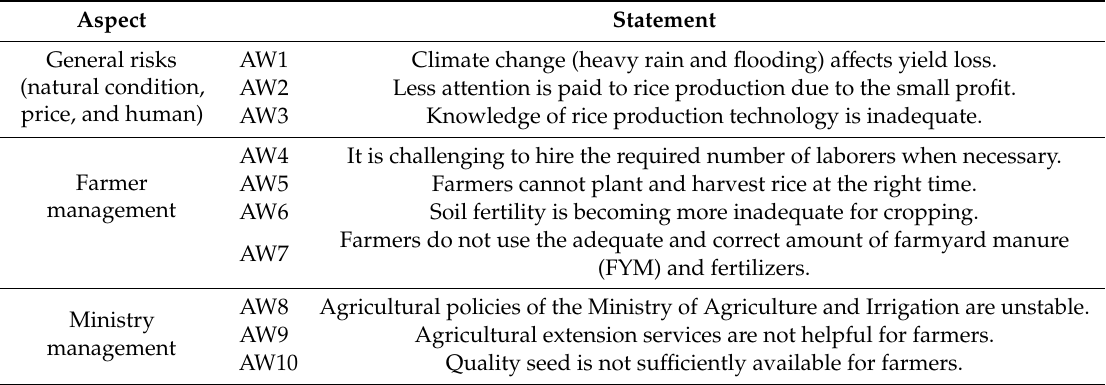
Table 3. Aspects and statements to measure farmers’